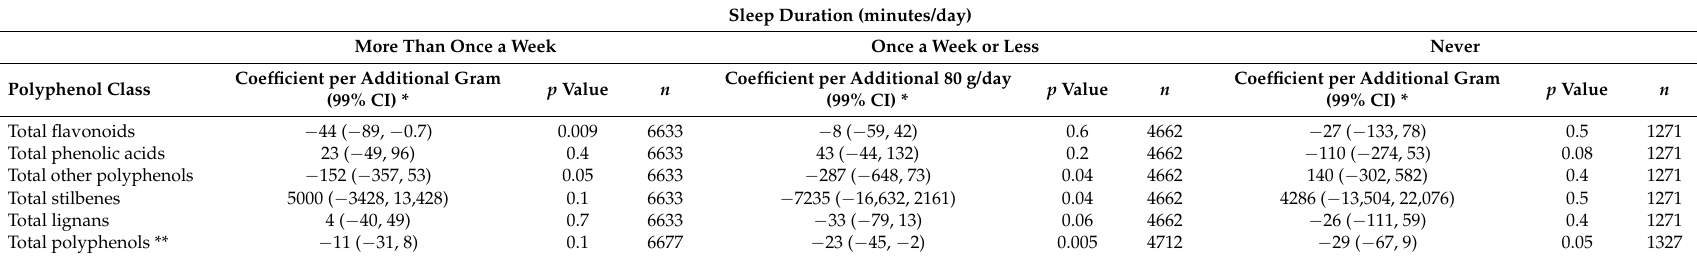
Table A5. Prospective associations between polyphenol content from fruit and vegetable intakes and sleep duration for women from the UKWCS based on alcohol consumption frequency.